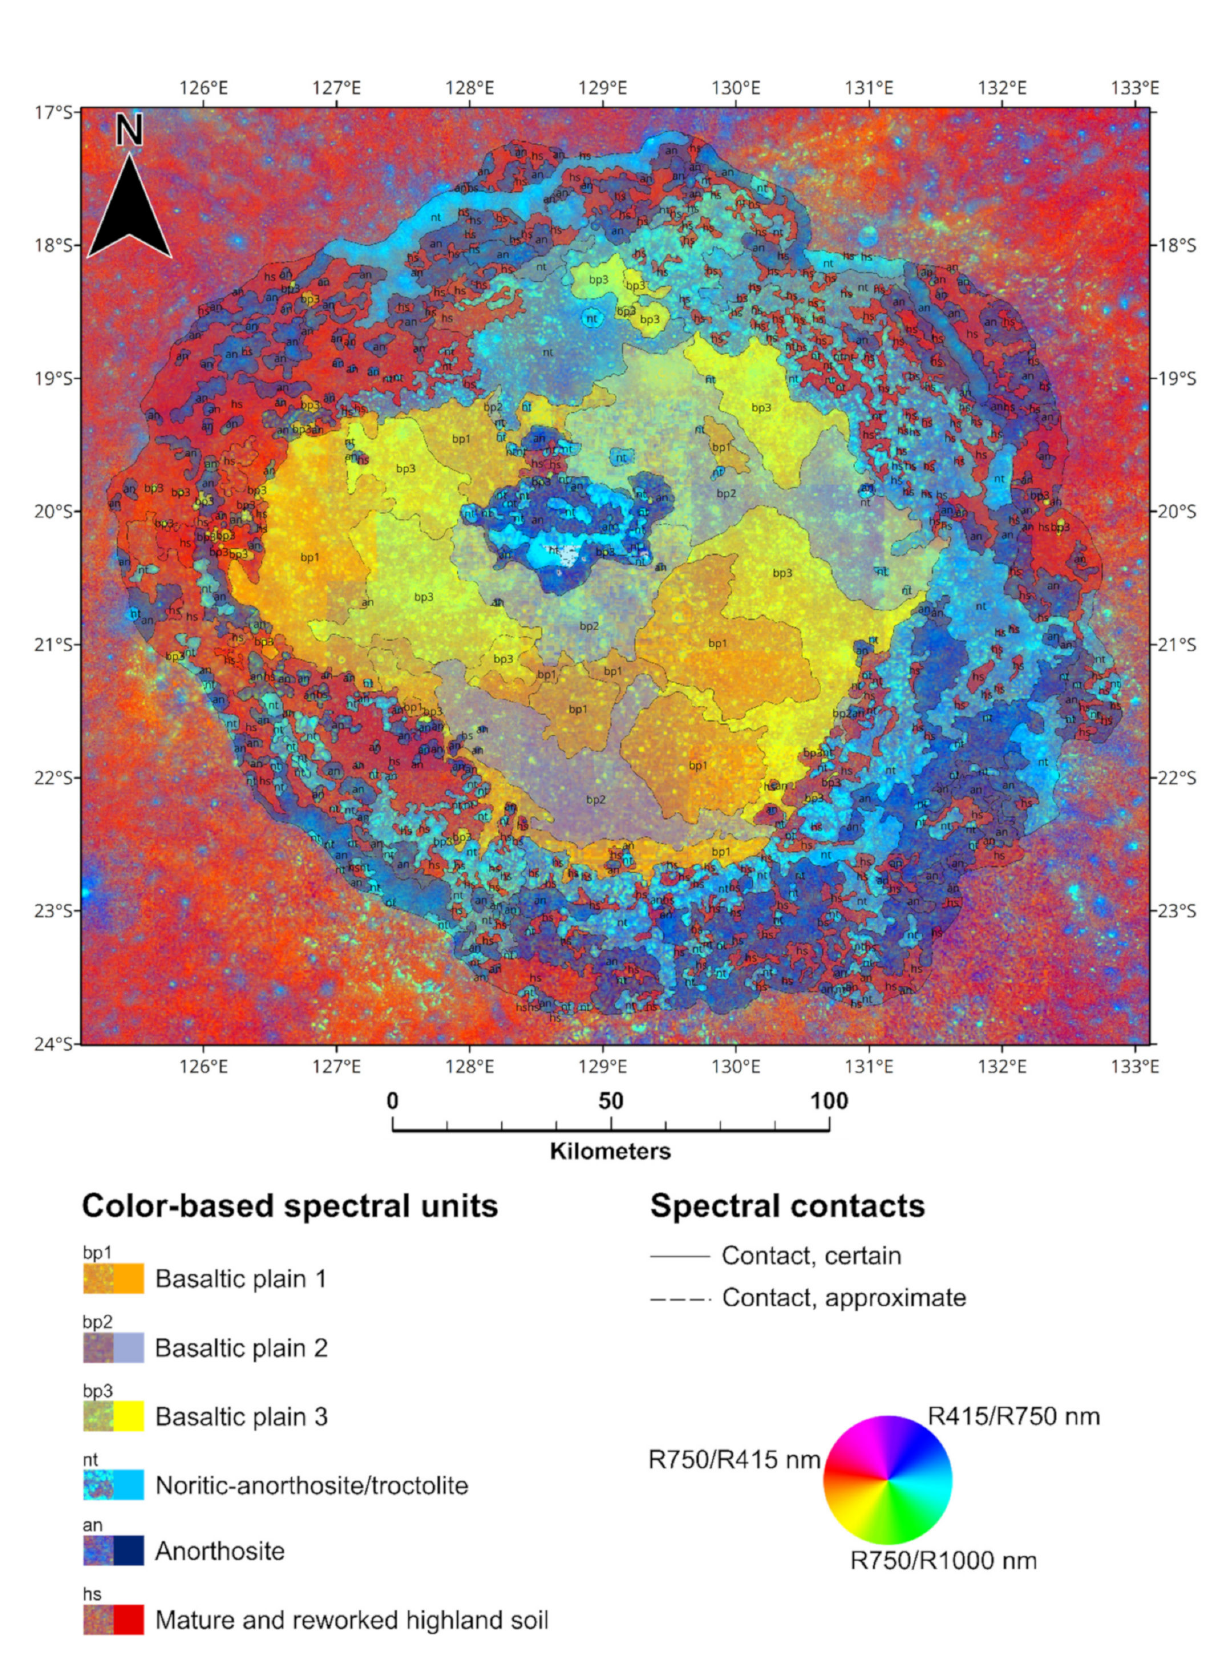
Figure 9. Color-based spectral map of the Tsiolkovskiy crater visualized on top of the Clementine UVVIS Warped Color Ratio mosaic [19]. Refer to the text for unit